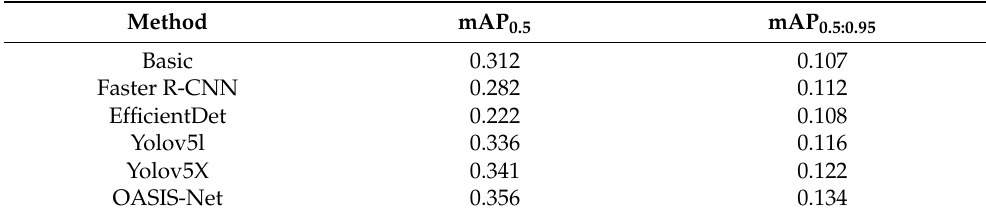
Table 2. Comparison of the mean average precision (mAP) for efflorescence